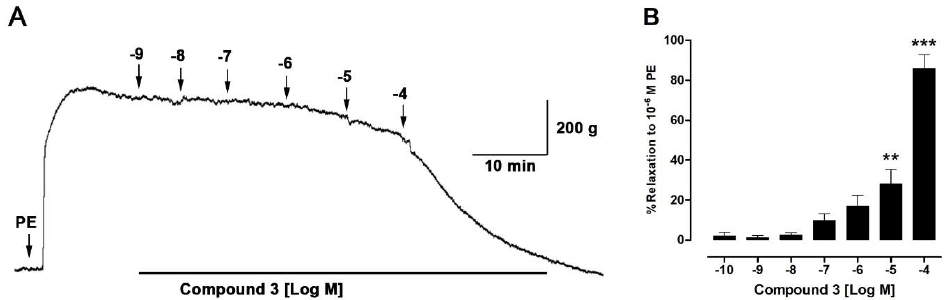
Figure 9. Sakuranetin causes vascular relaxation in intact aorta. Original record of the vascular effect of sakuranetin (compound 3 ) in intact rat aorta ( A ). Tissue was pre-contracted with 10 −6 M PE, and then, the cumulative concentrations of sakuranetin (10 −9 –10 −4 M) were added in the bath ( B ). Data are the SEM of 3 independent experiments. ** p < 0.01 and *** p < 0.001 vs. 10 −9 M compound 3 .